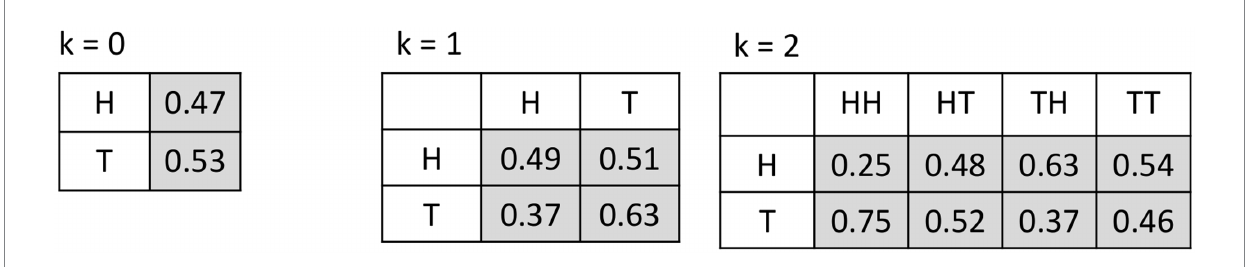
FIGURE 2 Example transition probability matrices for orders k = 0, 1, and 2. For the 0th order, there is no dependency on previous choices, and the two values represent the probabilities for the subsequent choice to be “H” or “T.” For higher order, each column corresponds to a possible sequence of previous choices and gives the probabilities for the subsequent choice under the condition that that sequence occurred. For example, in k = 2, after the choice pair “H-H,” the probability to choose a “T” is three times as large as the probability to choose another